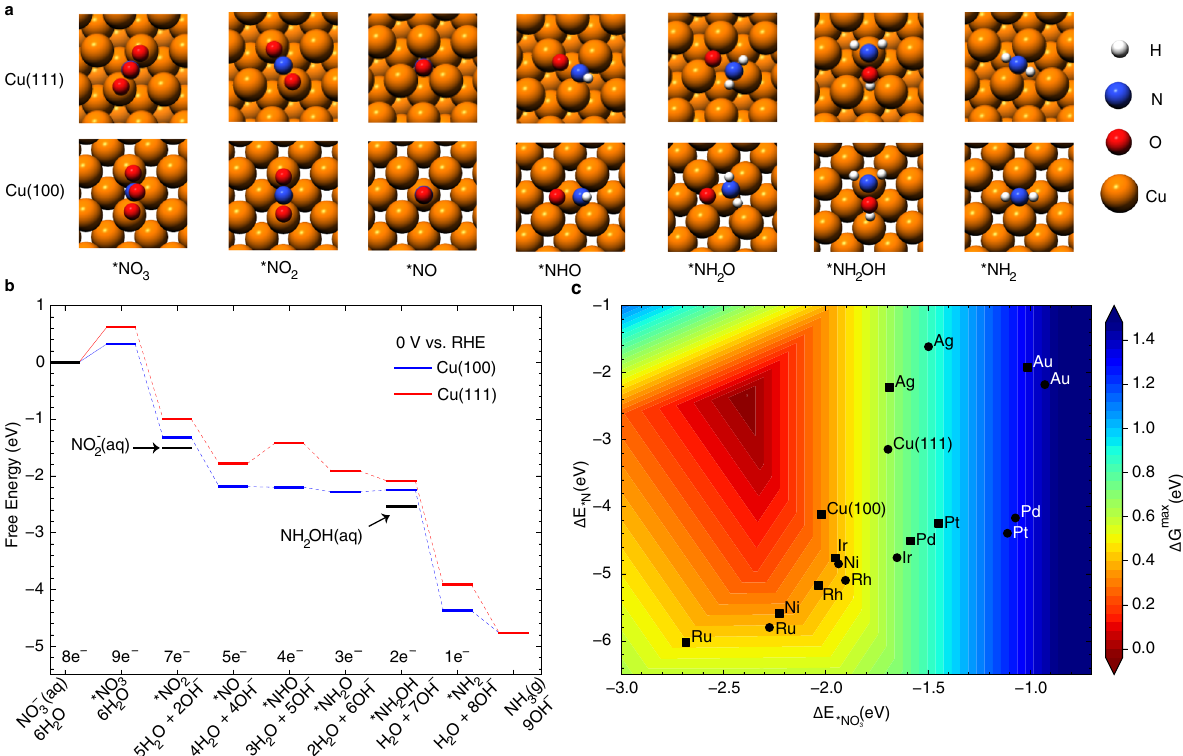
Fig. 1 Reaction pathways of NO 3 RR to NH 3 and the activity volcano plot. a Adsorption con fi gurations of reaction intermediates (top view) are shown (Cu: orange-red, N: blue, O: red, H: gray). b Free energy pro fi les of NH 3 formation from NO 3 − reduction on Cu(100) and Cu(111) at 0 V vs. RHE from grand- canonical DFT calculations. The free formation energies of intermediate products NO 2 − (aq) and NH 2 OH(aq) are marked. c The activity volcano plot of NO 3 RR to NH 3 using adsorption energies of the bridge-bidentate *NO 3 and hollow *N as reactivity descriptors. Circle and square symbols represent (111) and (100) metal surfaces,